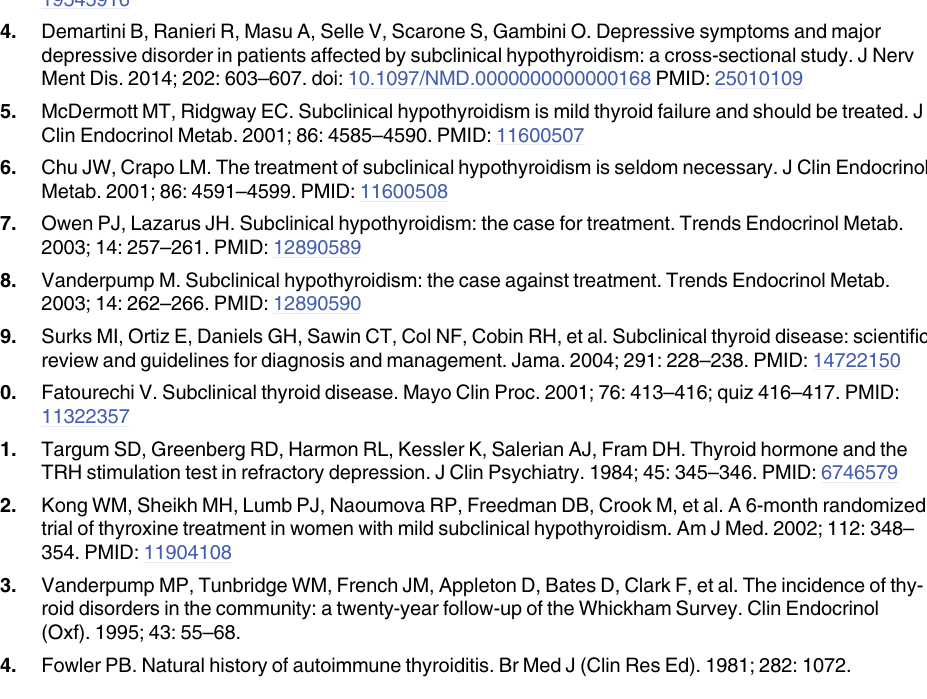
PLOS ONE | DOI:10.1371/journal.pone.0154846 May 2,